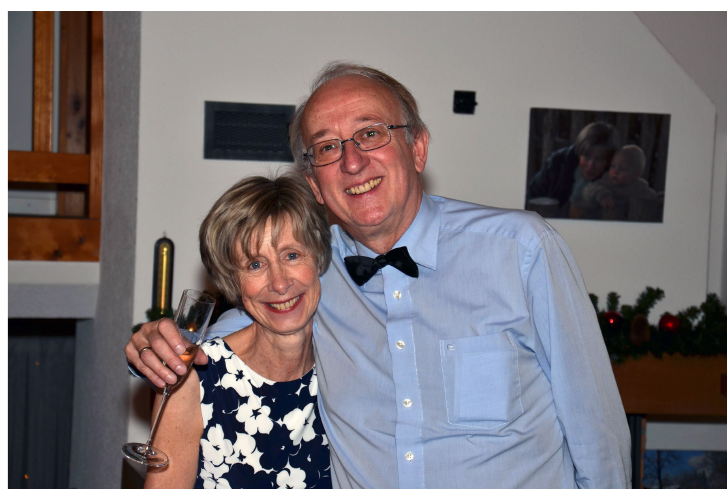
Figure 1: Gerda and Paul, Oberrohrdorf (Switzerland), Christmas